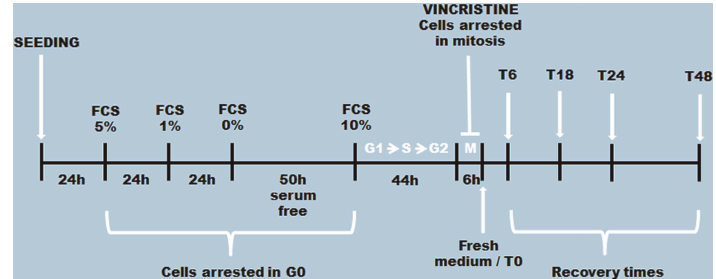
Figure 1. Cell synchronization protocol by double blockade in the A549 cell line. The schedule shows the period of fetal calf serum (FCS) deprivation and vincristine exposure. It also shows the different times of recovery (T) after vincristine removal (6, 18, 24 and 48 h).